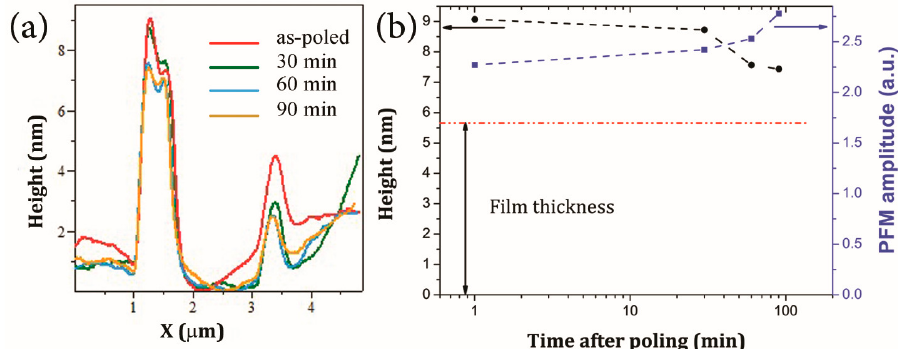
Figure 5. ( a ) Evolution of the topography cross-section with time; ( b ) average height and PFM amplitude of the peak over measuring time created by the +20 V poled area. The red line shows the initial thickness of the